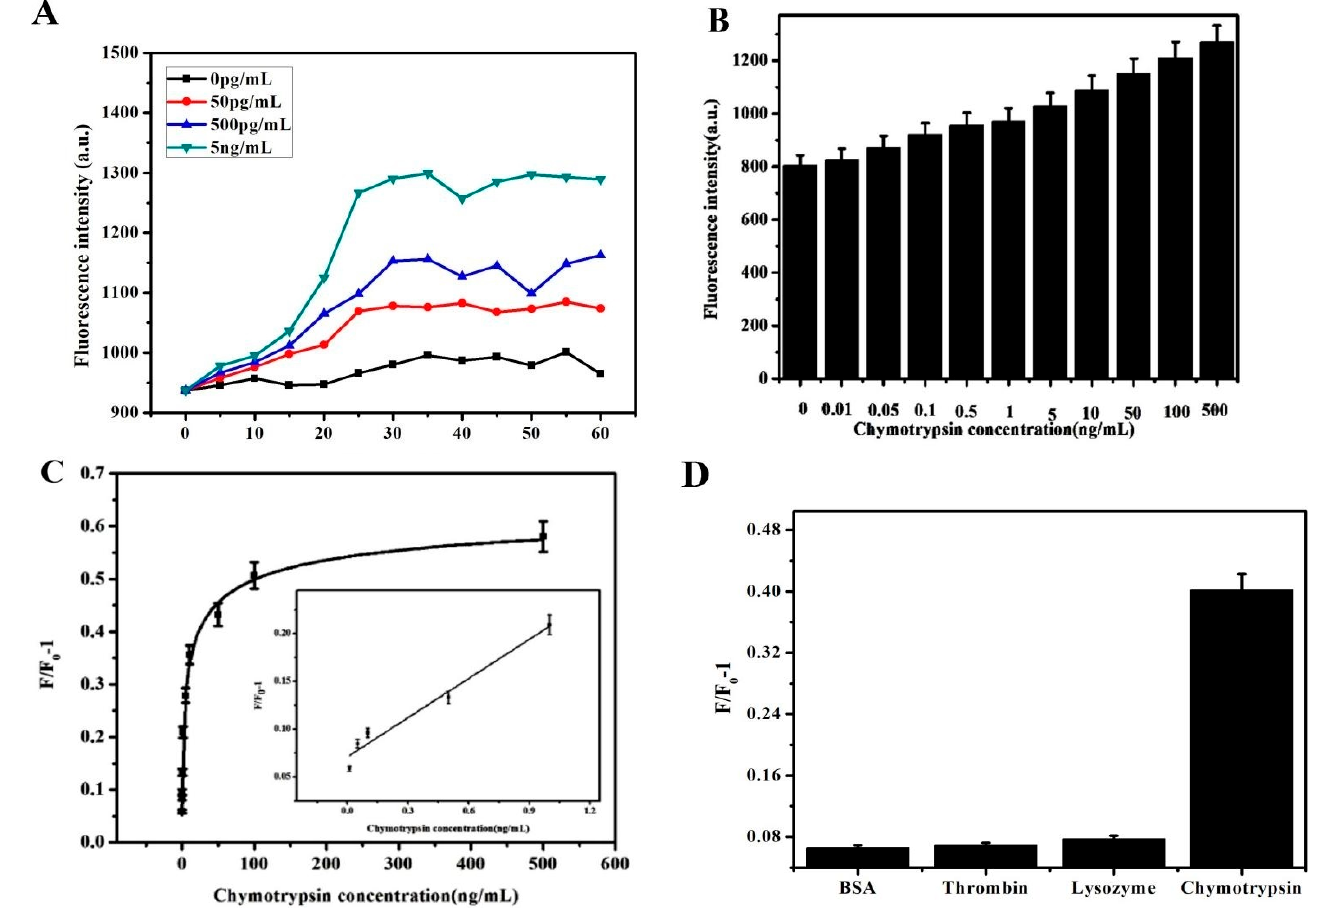
Figure 4. ( A ) The fluorescence intensity of the sensor with three kinds of concentrations (50, 500, and 5 ng mL − 1 ) of chymotrypsin with different time. ( B , C ) Detection of chymotrypsin using CuNC–peptide sensors. ( D ) The intensity of fluorescence caused by 10 ng mL − 1 IgG, chymotrypsin, thrombin, VEGF, BSA, and lysozyme. (The sample number was 5).